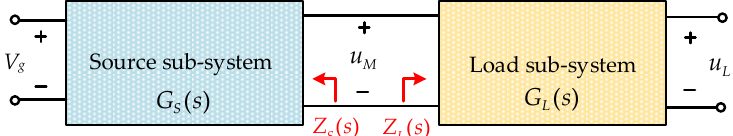
Based on the impedance model obtained in (18), the inter connection of the sub-system for the system is shown as Figure 6. Z S ( s ) and Z L ( s ) are the source impedance and the load impedance of the MVDC distribution system, i.e., the transmission line inductance L S and the input impedance of the ISOP DCT, respectively. G S ( s ) and G L ( s ) are the transfer functions of the source sub-system and the load sub-system, respectively.